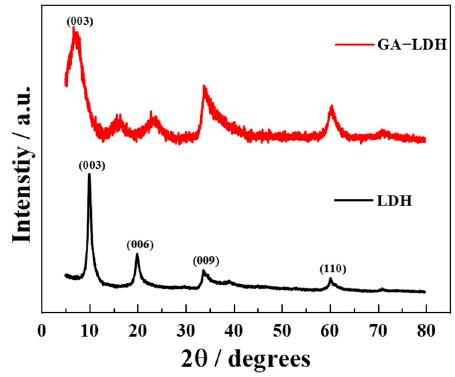
Figure 4. XRD patterns of LDH and GA − LDH.